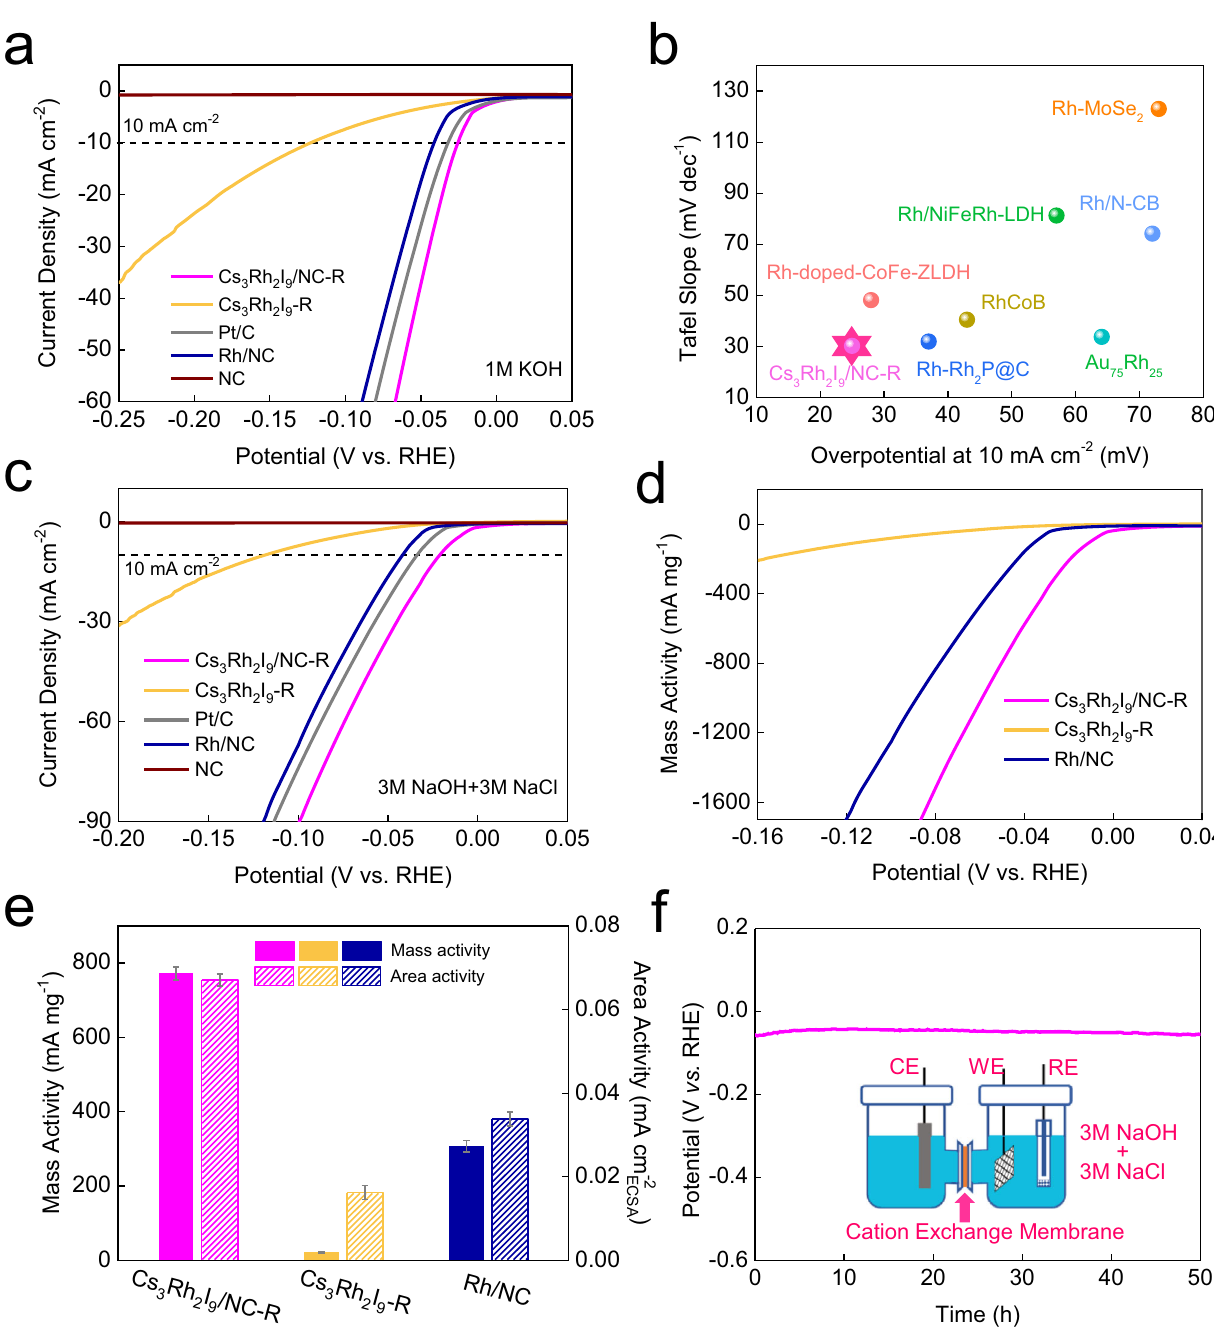
Fig. 5 | HER activity in 1.0M KOH and chlor-alkali electrolyte. a LSV curves of variouselectrocatalystsincludingcommercialPt/C(Ptcontent:20wt.%)coatedon rotating glassy carbon electrode (GCE, 1600 rpm) in 1.0M KOH. The catalyst loading amountonGCE is0.764mgcm − 2 . For Rh-based samples, the calculated Rh loading amounts on GCE are 0.045, 0.090 and 0.053mgcm − 2 for Cs 3 Rh 2 I 9 /NC-R, Cs 3 Rh 2 I 9 -R, and Rh/NC, respectively. b Comparison of overpotential at 10mAcm − 2 andTafelslopeforvariousRh-basedcatalystsin1.0MKOH. c LSVcurvesofvarious